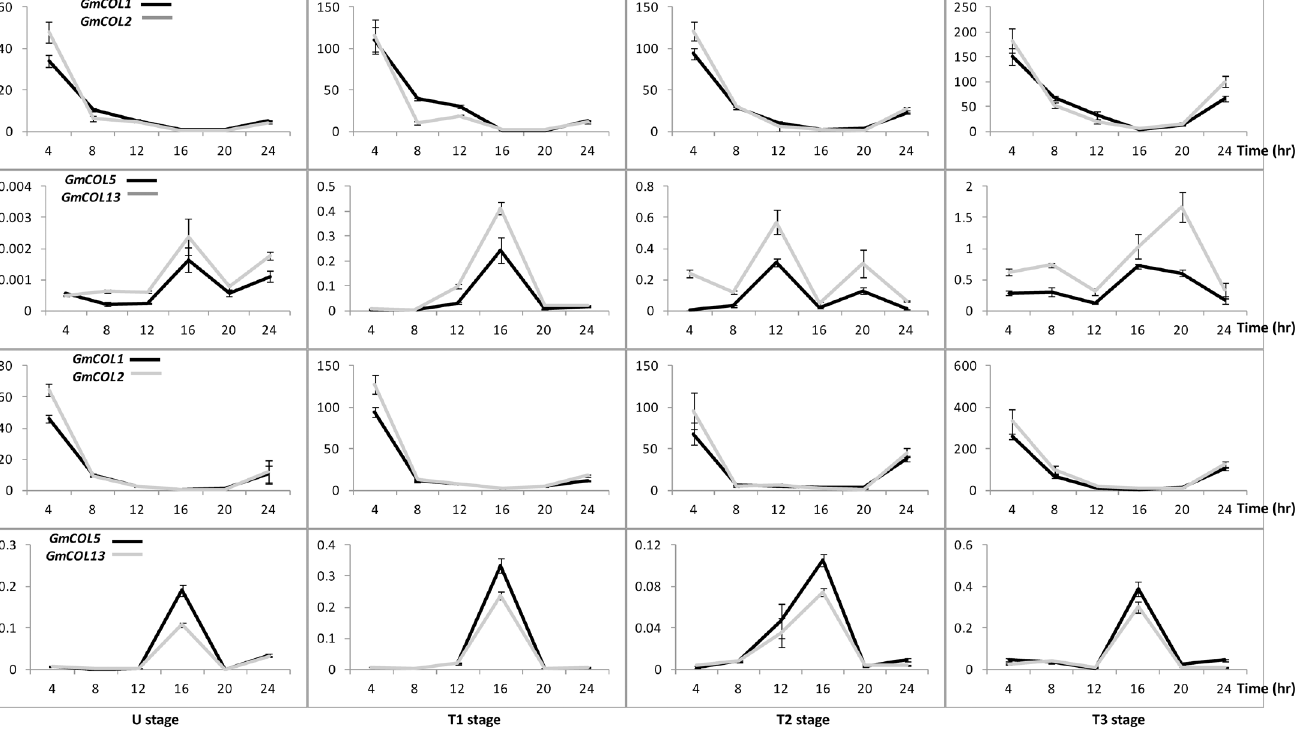
Fig 8. The diurnal rhythm of GmCOL expression in cultivars Heihe 35 and Beidou 51 at different stages. Relative expression levels (REL) were analyzed by RT-qPCR and normalized to UKN1 . Averages and standard errors are the result of three replicates. For detailed information on stages and sampling, see Materials and Methods